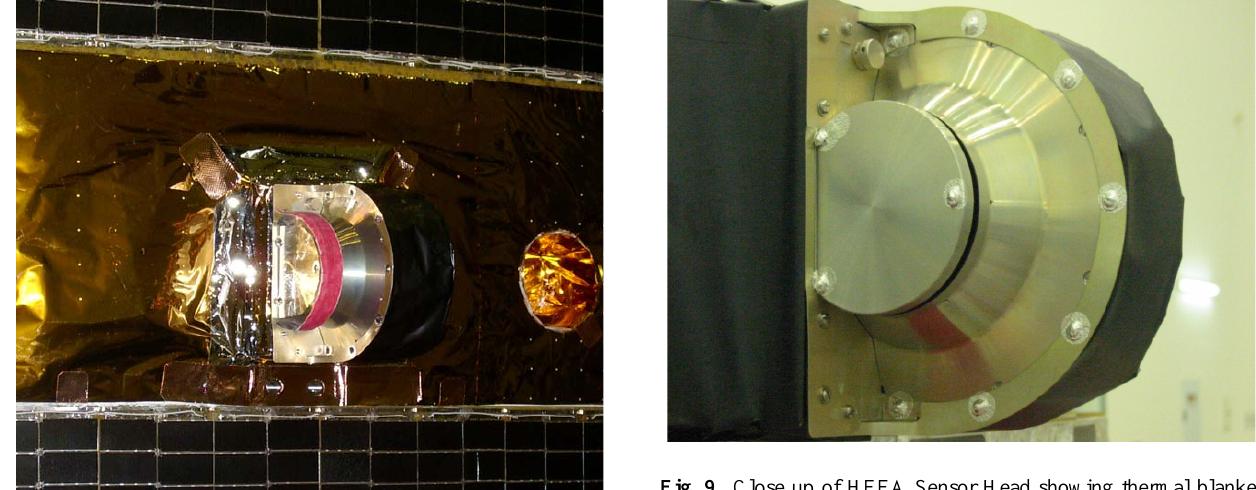
Fig. 9. Close up of HEEA Sensor Head showing thermal blanket Figure 9. Close up of HEEA Sensor Head showing thermal blanket closeout; note closeout; note electrically conductive material places over the epoxy electrically conductive material places over the epoxy used to lock the screw heads. used to lock the screw Fig. 8. Photograph of TC-2 PEACE Sensor head showing arrange- Figure 8. Photograph of TC-2 PEACE Sensor head showing arrangement of electrostatic ment of electrostatic conductive materials; spacecraft and PEACE conductive materials; spacecraft and PEACE thermal blankets and also solar cells above thermal blankets and also solar cells above and below the experi- and below the experiment platform. Note the larger collimator of a LEEA sensor vs. the ment platform. Note the larger collimator of a LEEA sensor vs. the TC-1 HEEA sensor. TC-1 HEEA sensor.